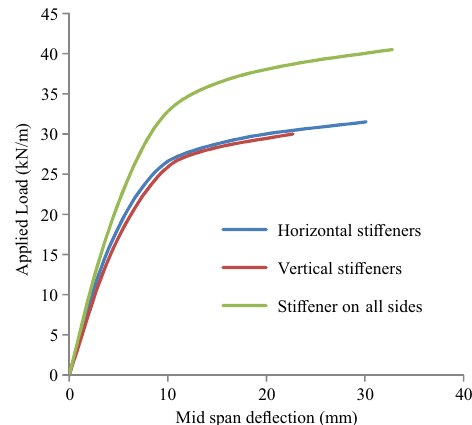
Fig. 16. Load vs mid span deflection for beam of different stiffeners position subjected to point load